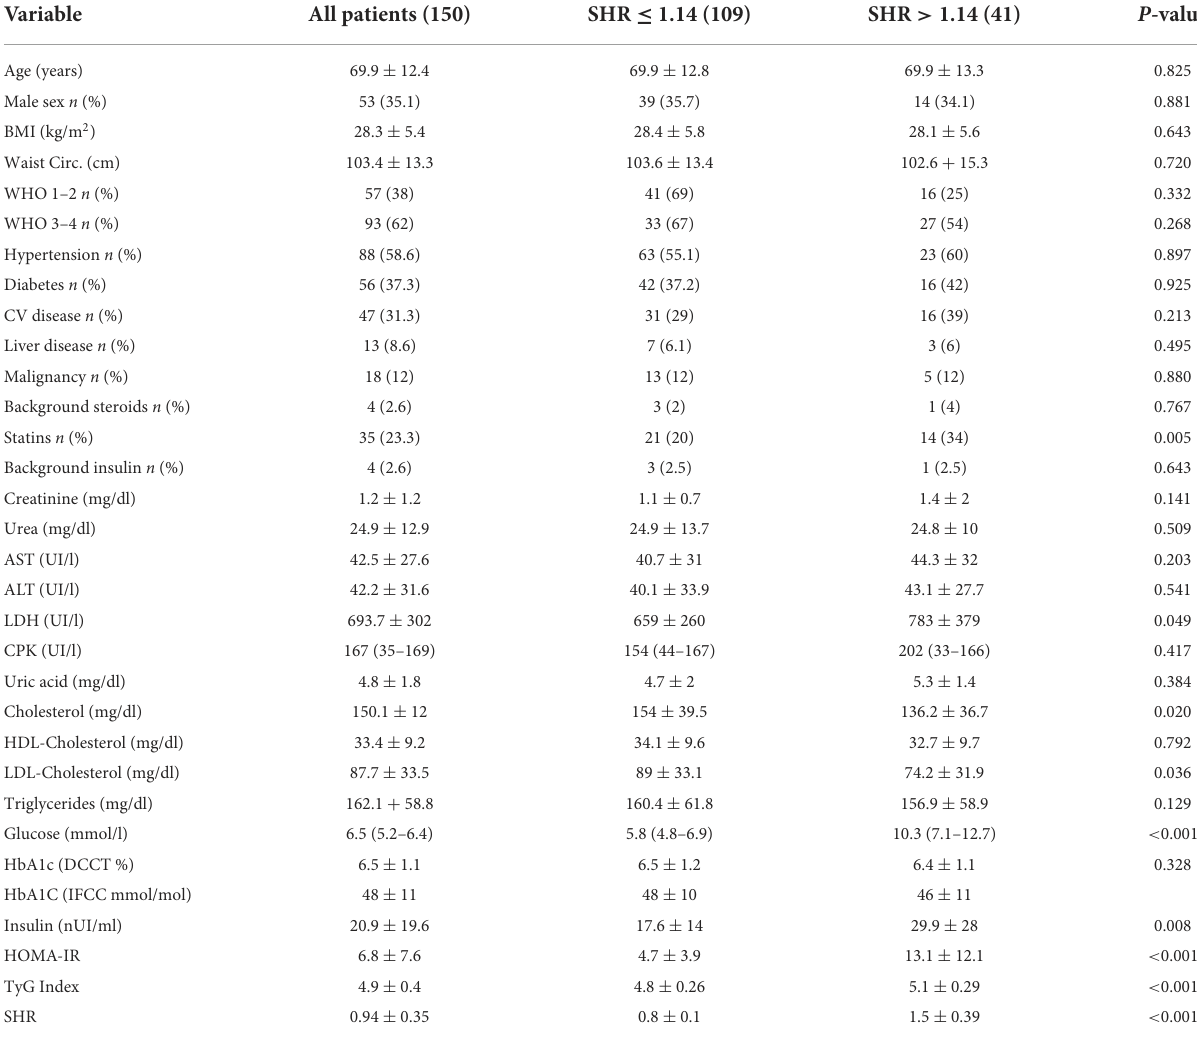
TABLE 1 Clinical characteristics and biochemical variables in patients hospitalized with COVID-19 infection who were grouped according to a Stress Hyperglicemia Ratio (SHR) ≤ 1.14 or > 1.14. Variable All patients